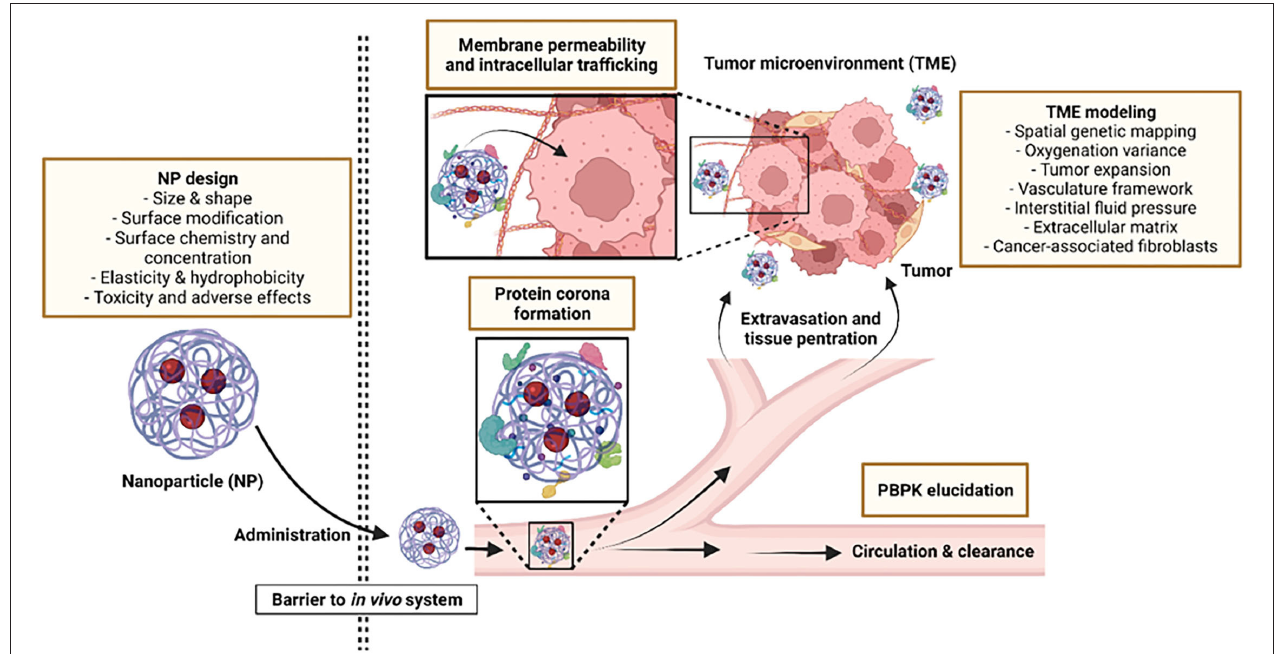
FIGURE 1 | Aspects where computational modeling can be applied to improve NP design and